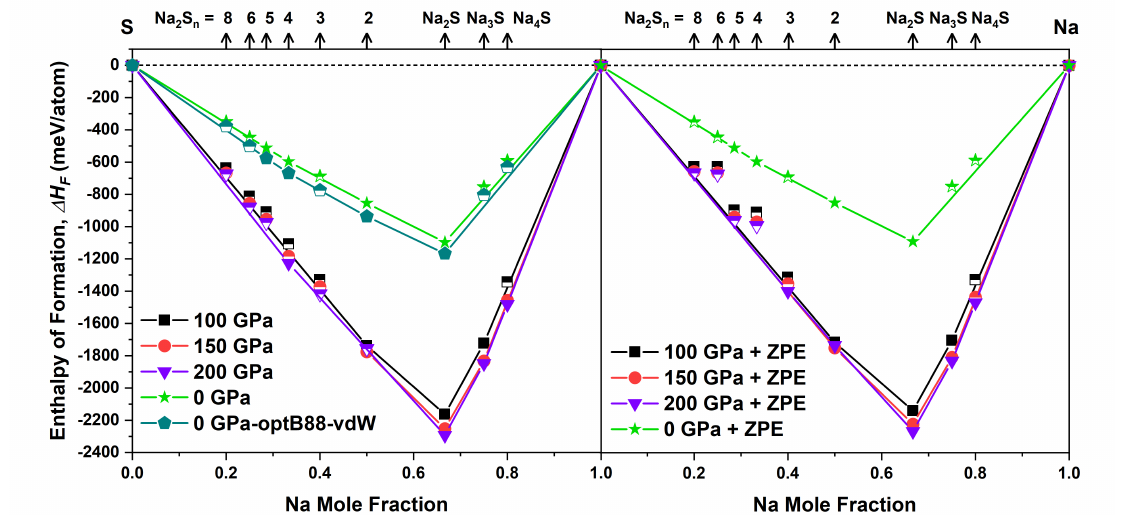
Figure 1. ( left ) Enthalpy of formation, ∆ H F , of the Na x S y compounds with respect to solid Na and S as computed with the optB88-vdW functional at 0 GPa and the PBE functional between 0–200 GPa. ( right ) PBE results including the zero point energy (ZPE). Closed symbols lie on the convex hull (denoted by solid lines), open symbols lie above it. ∆ H F was calculated using the enthalpies of the experimentally known structures: body-centered cubic (bcc, 0 GPa), face-centered cubic (fcc, 100 GPa) [58], cI 16 (150 GPa) [59,60], and hp 4 (200 GPa) [61] for Na, and α -S (0 GPa) [62]. Because the crystal structure